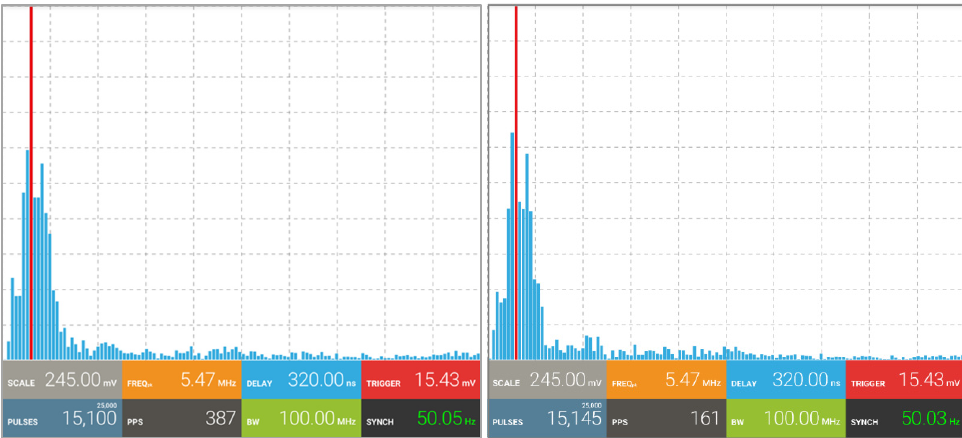
Figure 13. Typical frequency spectrum related to the PD pulse detected by the Pry-cam sensor with the sinusoidal ( left ) and the DCP waveforms with δ = 0.6 ( right ).